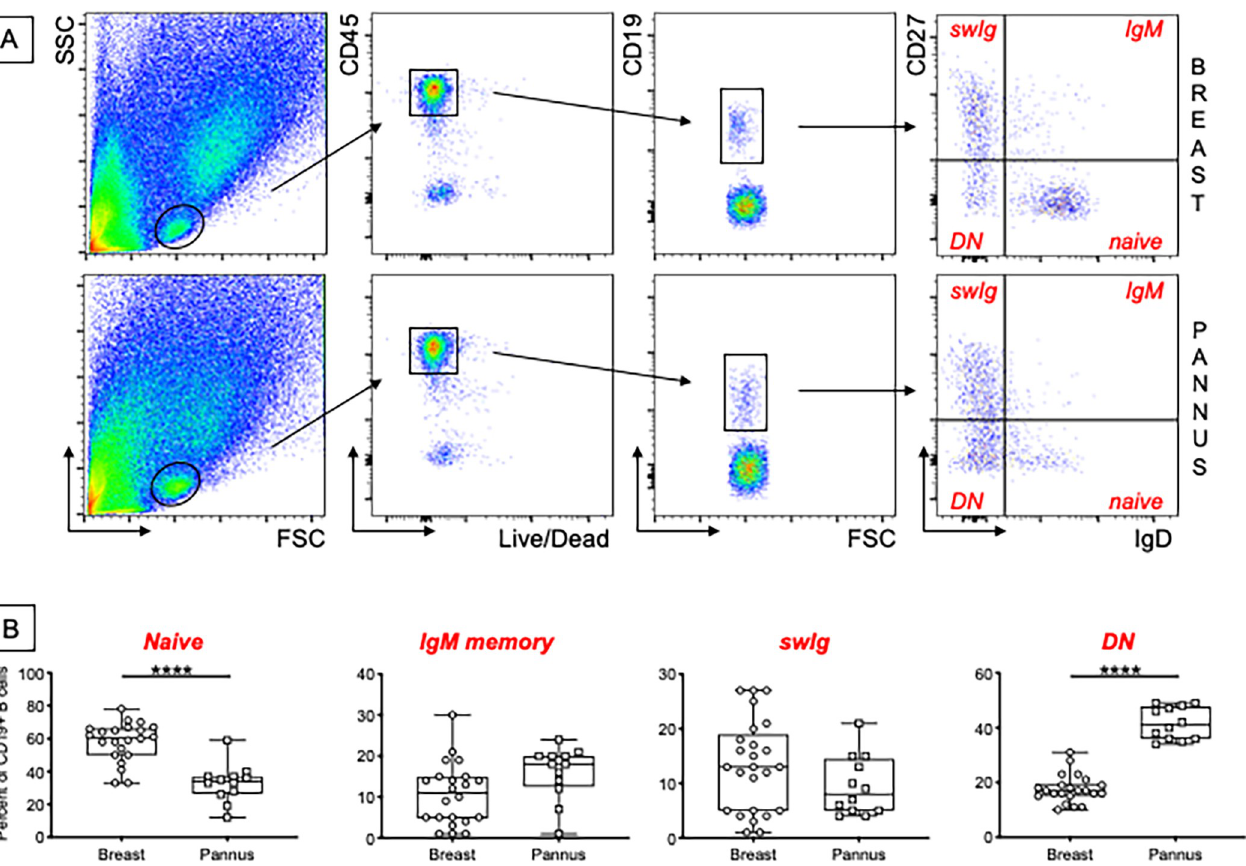
Fig 1. Lower frequencies of na ï ve and higher higher frequencies of DN B cells in the B cell pool of pannus versus breast. Unstimulated SVFs were membrane stained with Live/Dead detection kit and anti-CD45/CD19/CD27/IgD antibodies. A. Gating strategies and a representative dot plot from one breast (top) and one pannus (bottom) SVF sample to evaluate the major B cell subsets. B. Frequencies of na ï ve, IgM, swIg and DN B cells from all donors (means ± SE), gated on live CD45+ CD19+, are shown. Mean comparisons between groups were performed by Student’s t test (two-tailed). **** p < 0.0001. Each symbol represents an individual, n = 22 breast donors and n = 12 pannus